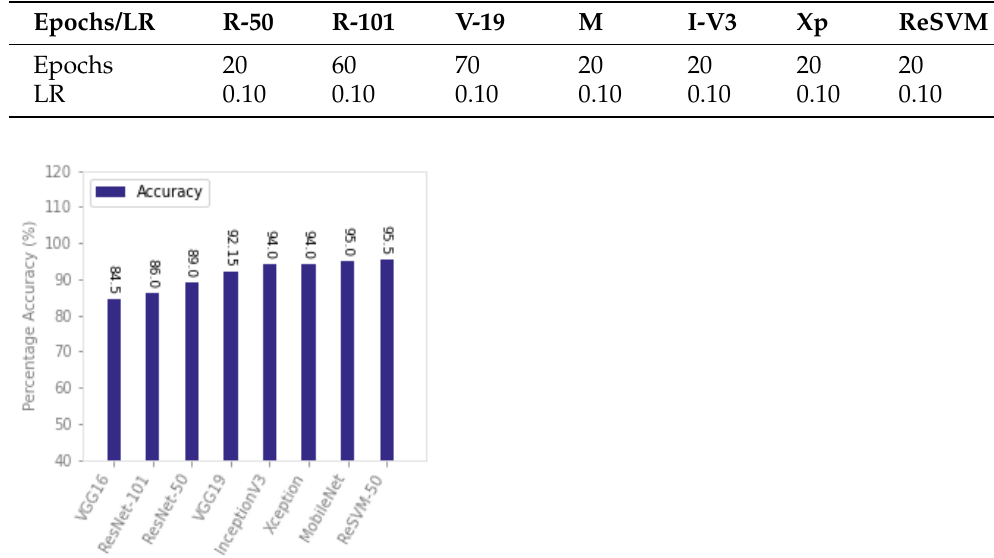
Figure 7. Comparison of ReSVM with existing state-of-the-art approaches in terms of percentage accuracy on SFDDD